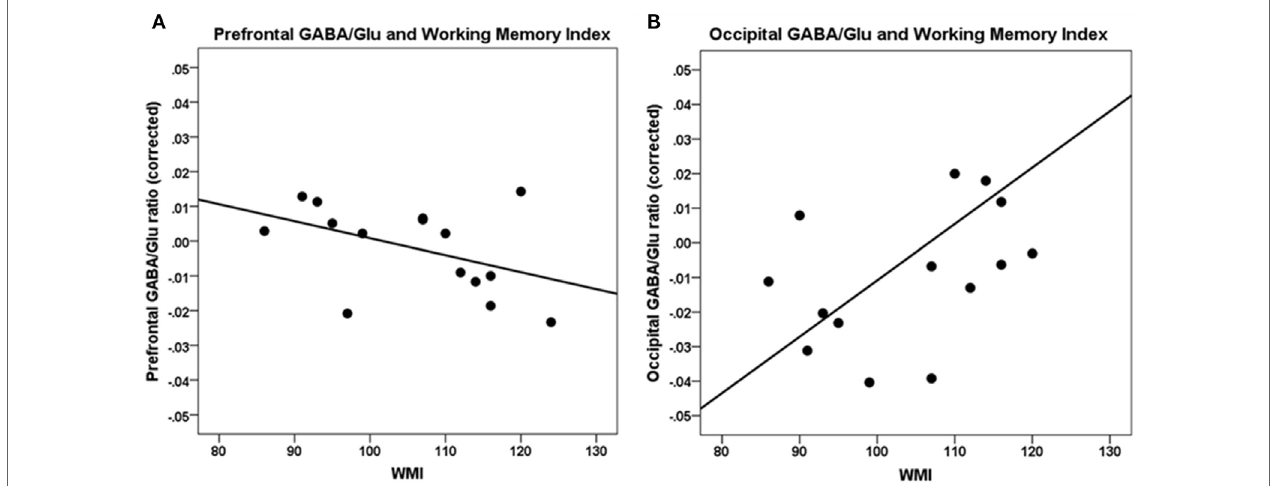
FigUre 3 | Correlations between working memory index (WMI) and GABA/Glu ratio. (a) Prefrontal GABA/Glu ratios are significantly correlated with WMI [ r (7) = − 0.80, p = 0.01]. (B) Occipital GABA/Glu ratios are not significantly correlated with WMI. Data are presented corrected for gray and white matter fractions, age, and